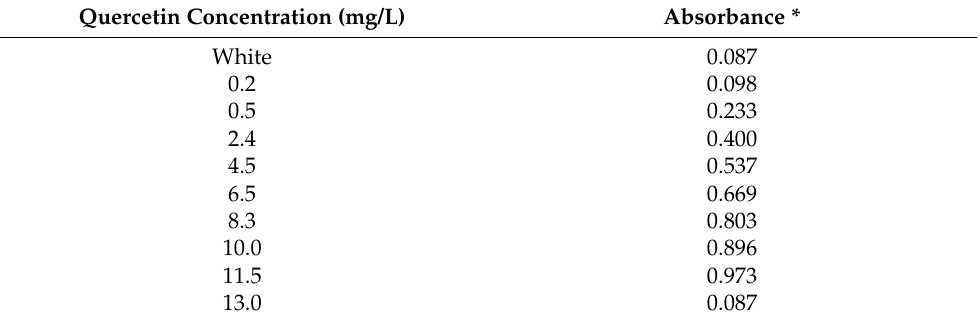
Table A2. Calibration curve for flavonoids content.